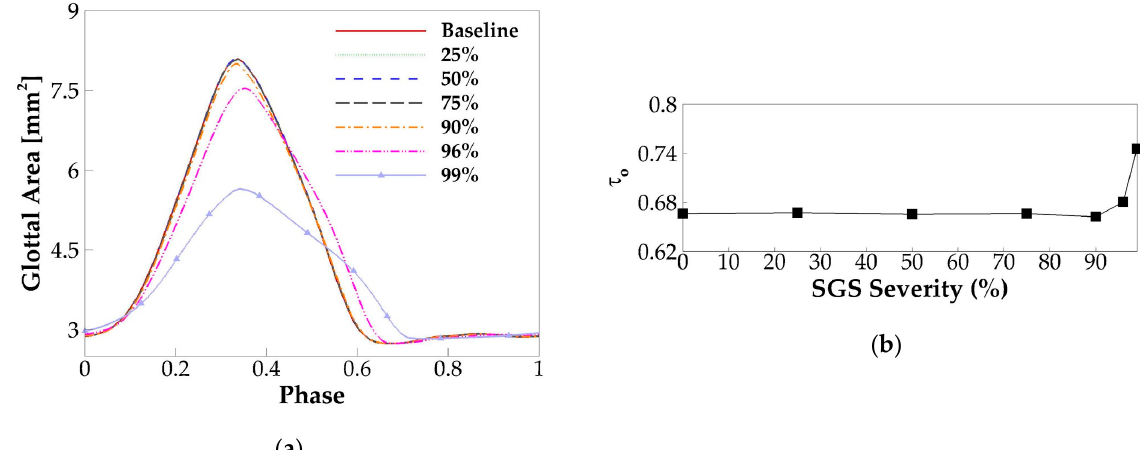
Figure 9. ( a ) The phase-averaged glottal area waveform for different SGS severities. ( b ) The open quotient versus SGS severity.